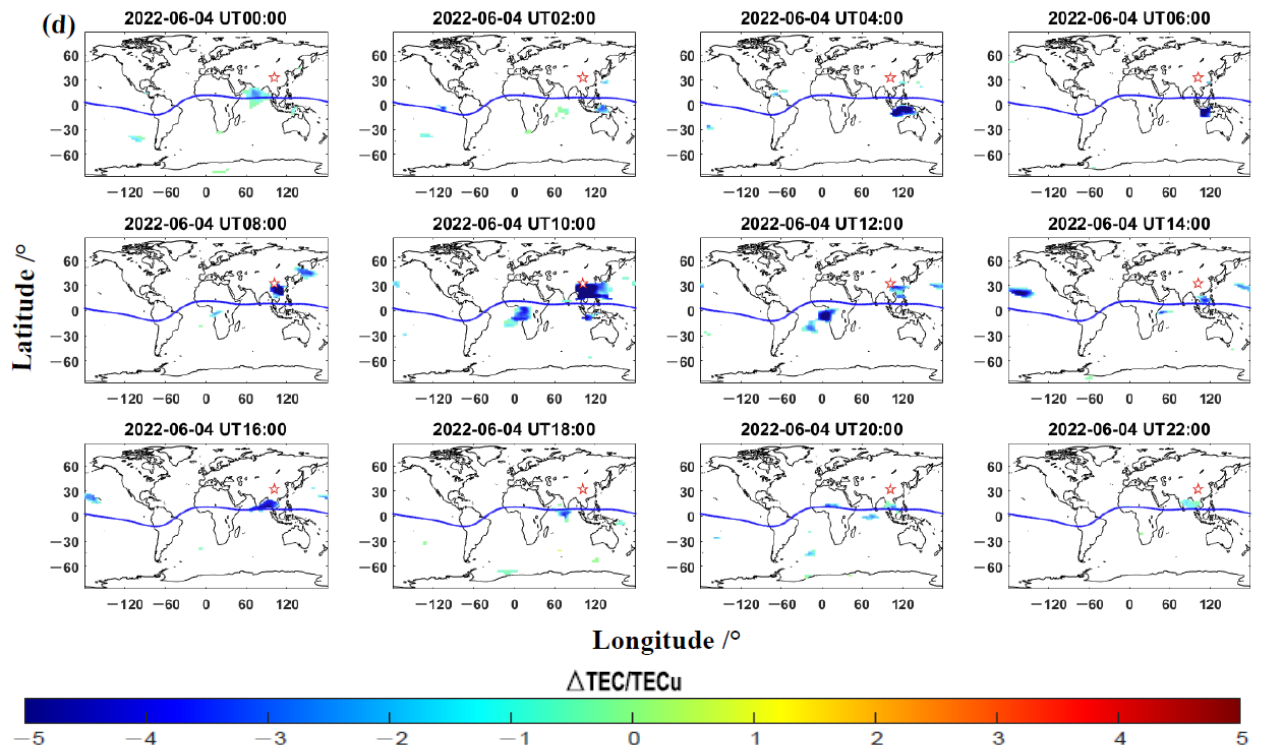
Figure 3. Anomalous distribution of GIM, where ( a )–( d ) denote the daily variation from 1 June to 4 June 2022. Each daily image contains 12 small images in a 2 h interval, the red star represents the epicenter, the blue line is the magnetic equator and UT is shown as the title on each panel.